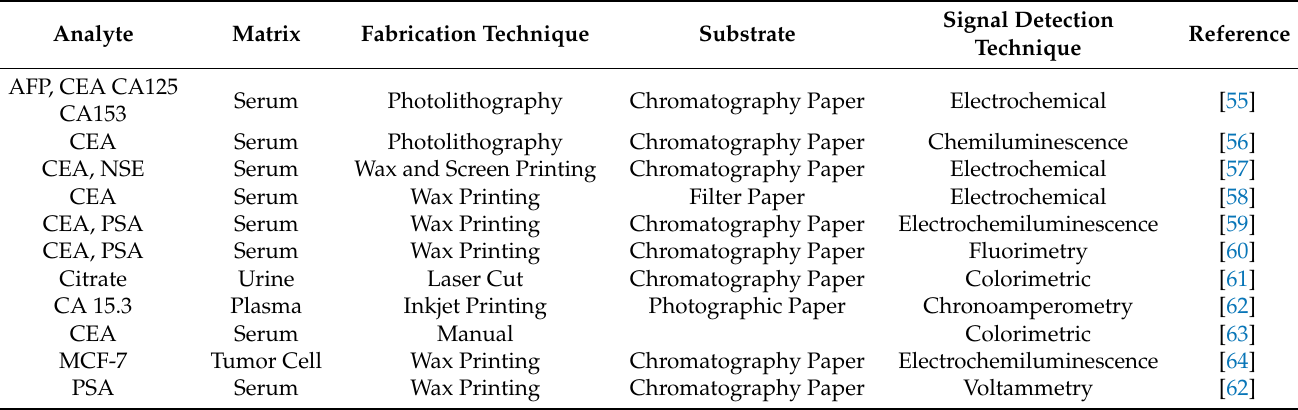
Table 1. µ PAD manufacturing techniques to detect different types of tumor